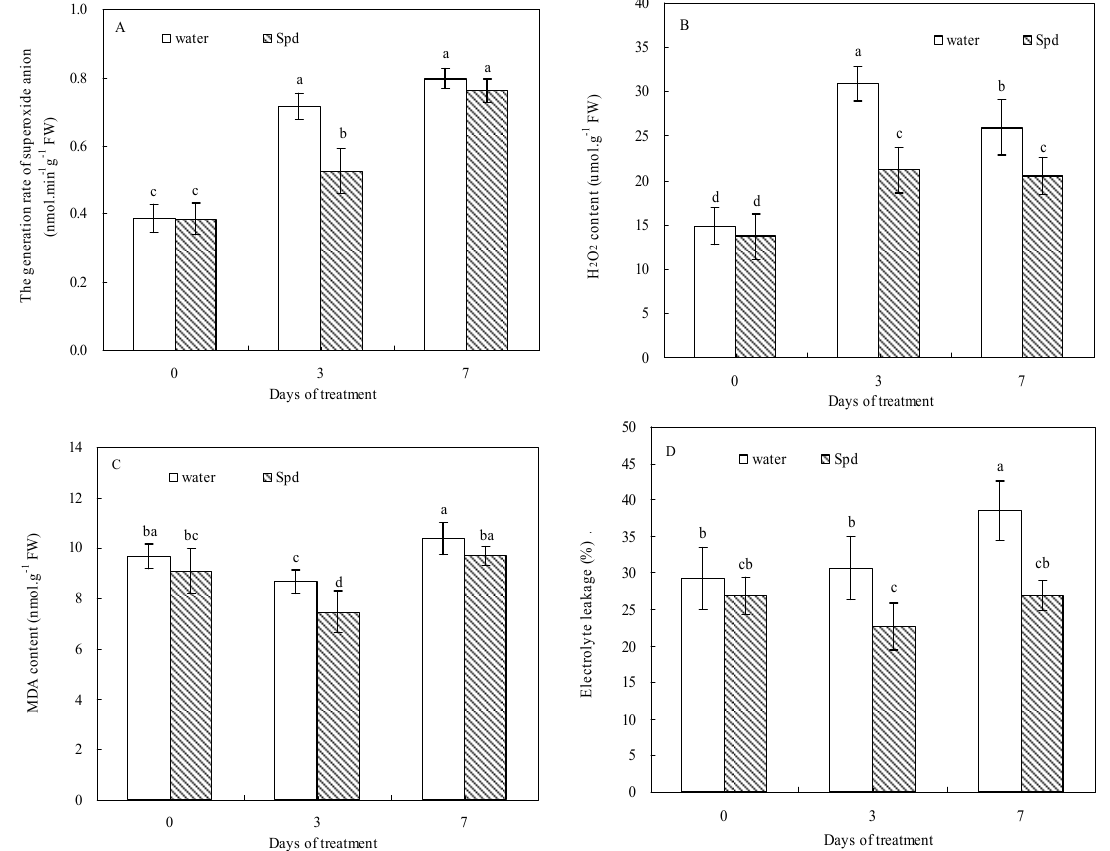
Figure 4. The effect of seed soaking with water or spermidine (Spd) on ( A ) the generation rate of superoxide anion (O 2 − ); ( B ) H 2 O 2 content; ( C ) MDA content and ( D ) electrolyte leakage (EL) in the process of seeds germination (7 days) under water stress induced by 15% PEG. Vertical bars indicate ± SE of mean ( n = 6). Different letters above columns indicate significant difference. LSD ( p ≤ 0.05).